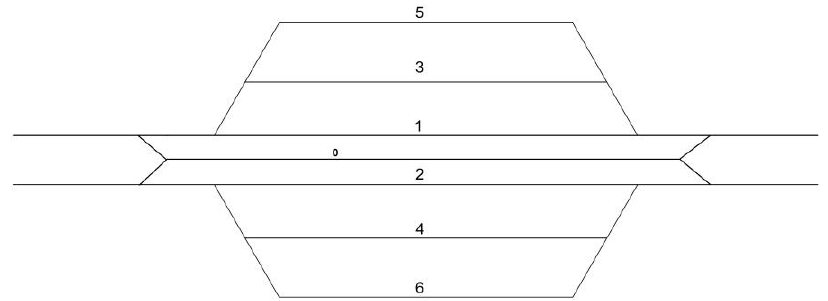
Figure 5. An alternative track layout diagram for a small overtaking station on a double-track line.